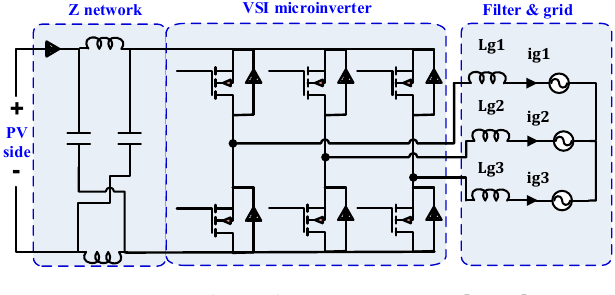
Figure 11. Classical Z-source inverter [94,95].